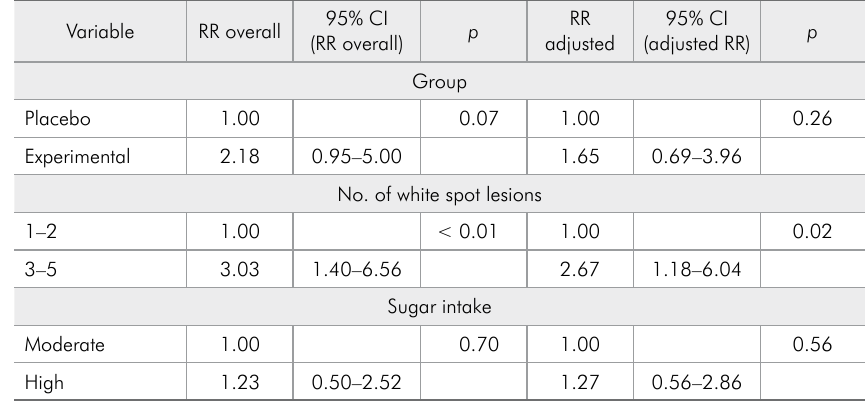
Table 2 - Overall Relative Risk (RR), adjusted RR and respective 95 % confidence intervals in the analysis of factors associated with presence of active white spot lesions after 8 weeks of